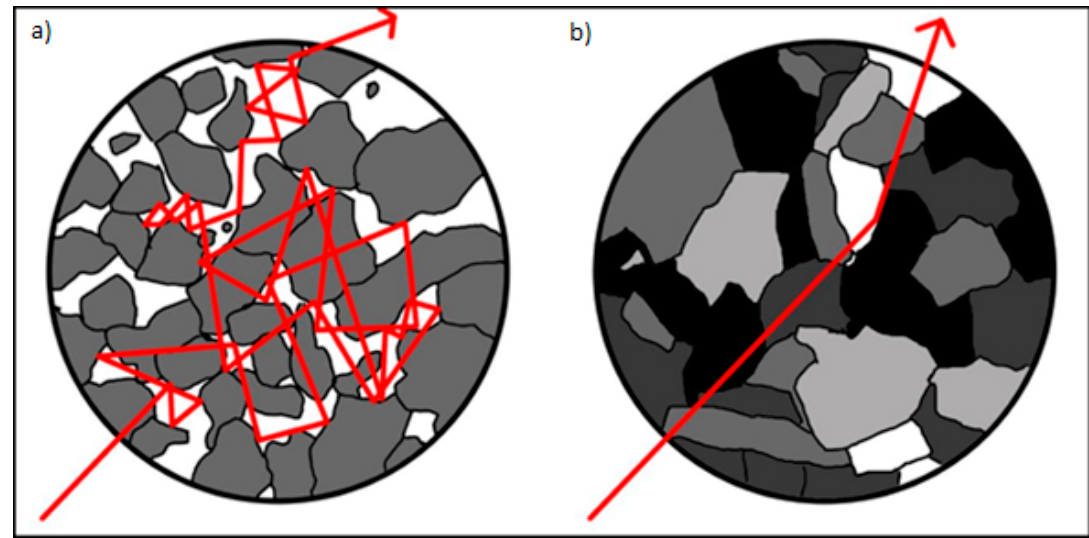
Figure 1. Representative scattering behaviour of seismic energy due to differences in medium structure. ( a ) Loosely consolidated media exhibit strongly multiple-to-diffusive scattering ray behavior; ( b ) Highly consolidated/crystalline media typically show weakly-to-single scattering characteristics.